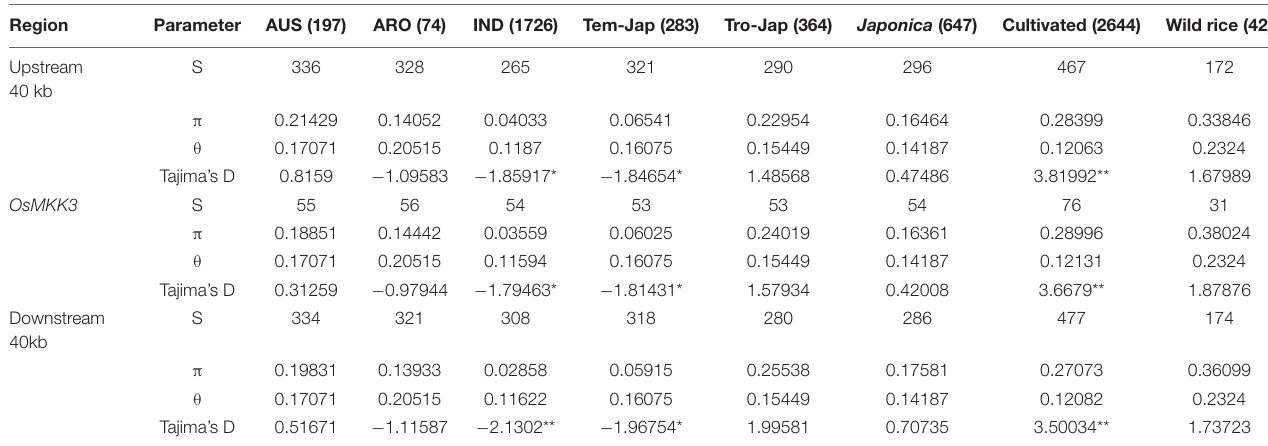
* and ** represent significant difference at 5% and 1% probability levels,